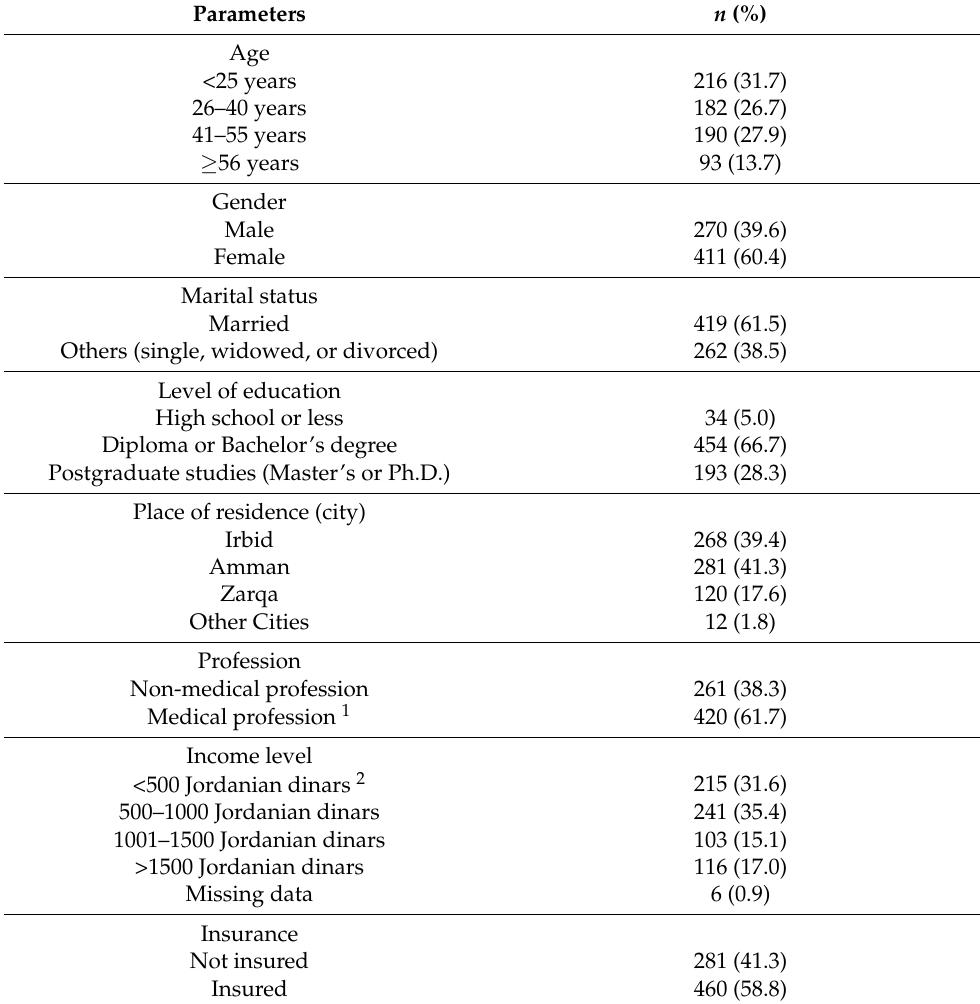
Table 1. Sociodemographic characteristics of the study participants ( n =